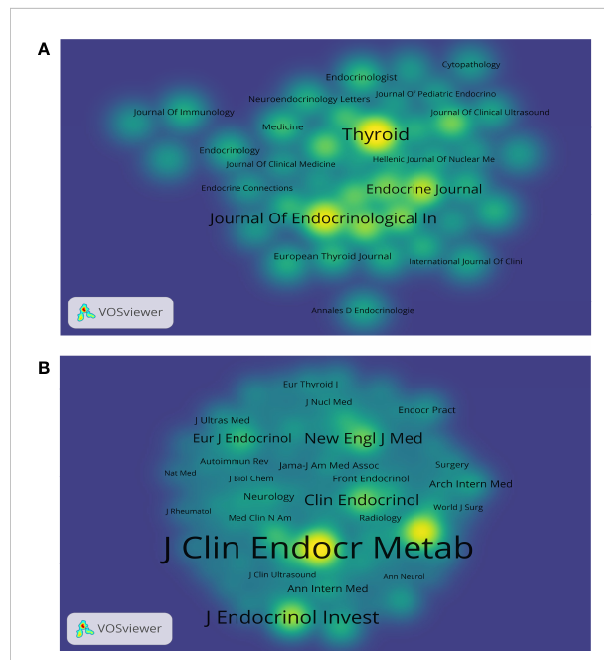
FIGURE 4 The density maps (A) Journals; (B) Co-cited journals. The size of the word and round, and the opacity of yellow are positively associated with the cited frequency (A) . The size of the word and round, and the opacity of yellow are positively associated with the co-cited frequency (B)